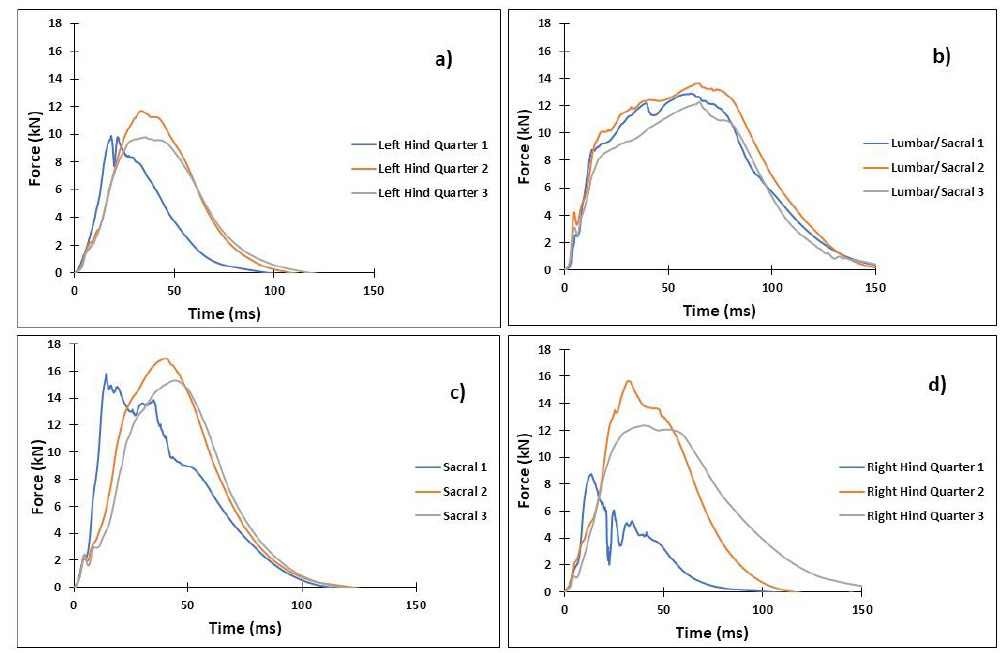
Figure 6. Un-helmeted drop test force–time history plots for horse 2. ( a ) Left hind quarter impact location. ( b ) Lumbosacral junction vertebrae impact location. ( c ) Sacral vertebrae impact location. ( d ) Right hind quarter impact location.